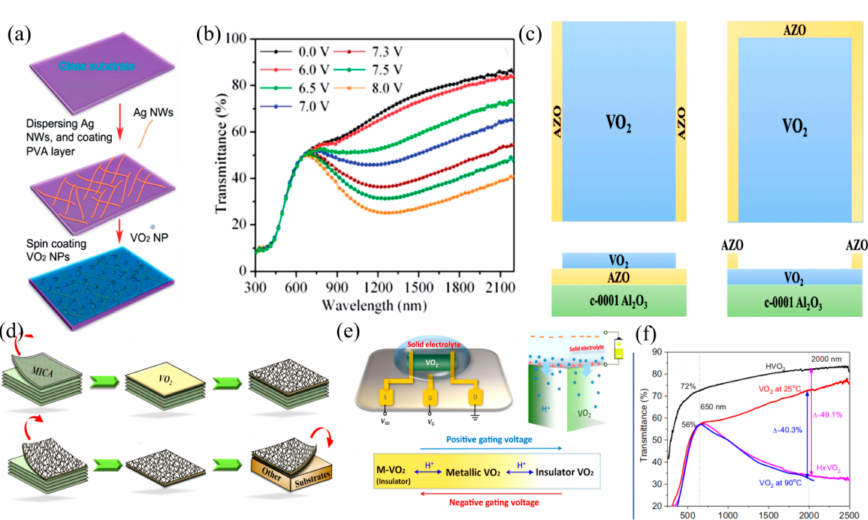
Figure 5. ( a ) The preparation process diagram of VO 2 NF/AgNWS electrochromic film on glass substrate. Reproduced with permission from [39]. Copyright 2014, Royal Society of Chemistry. ( b ) Transmission spectra of VO 2 NF/AgNWS electrochromic films under different applied voltages. Reproduced with permission from [39]. Copyright 2014, Royal Society of Chemistry. ( c ) VO 2 /AZO multilayer structure, AZO at the bottom and edge diagram. Reproduced with permission from